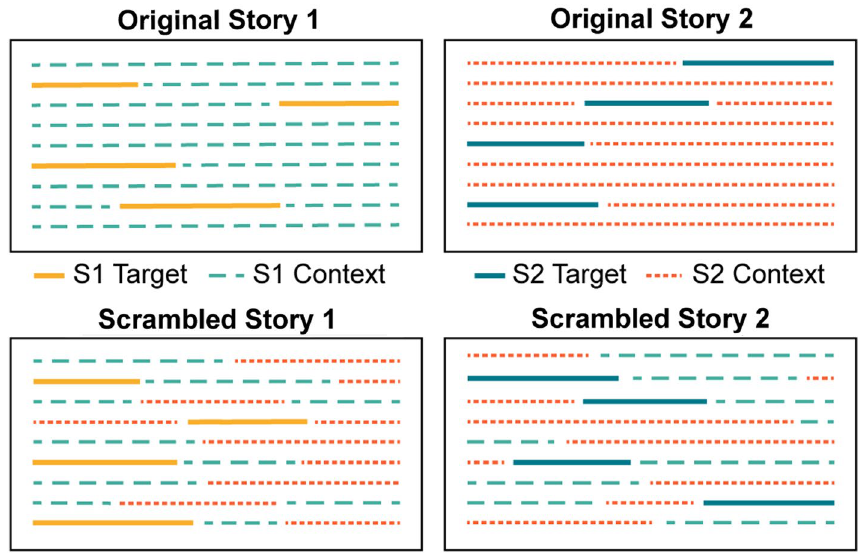
Figure 5. Stimulus schematic for Experiment 3. A schematic of the sentence structure of the original (top panel) and scrambled stories (bottom panel) is plotted. For the original stories, events were presented in their original order, whereas the scrambled stories contained the target phrases from one original story and a randomized mixture of the context sentences from both original stories. Target phrases/sentences used for intelligibility testing are plotted as solid lines (4 test sentences shown per story for simplicity), and context sentences are plotted as dashed lines. Note that the same target sentences are used in the original and scrambled